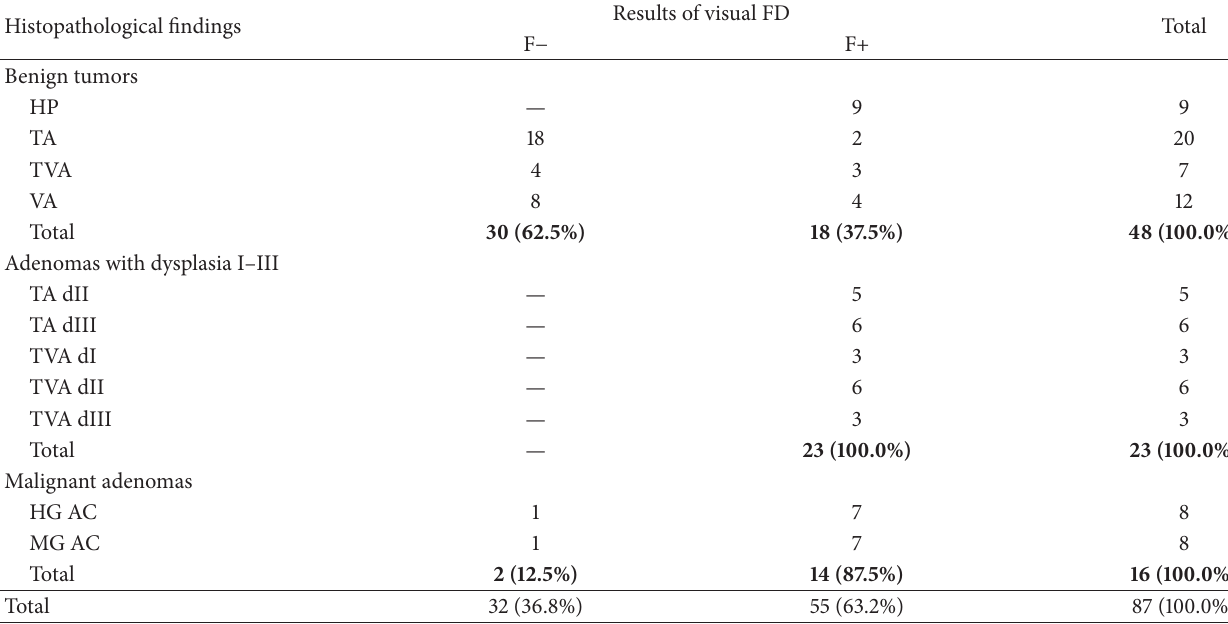
Results of visual FD